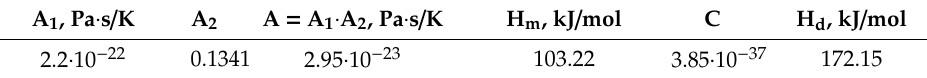
Table 2. Parameters of the She ffi eld equation of viscosity for α -phenyl- o